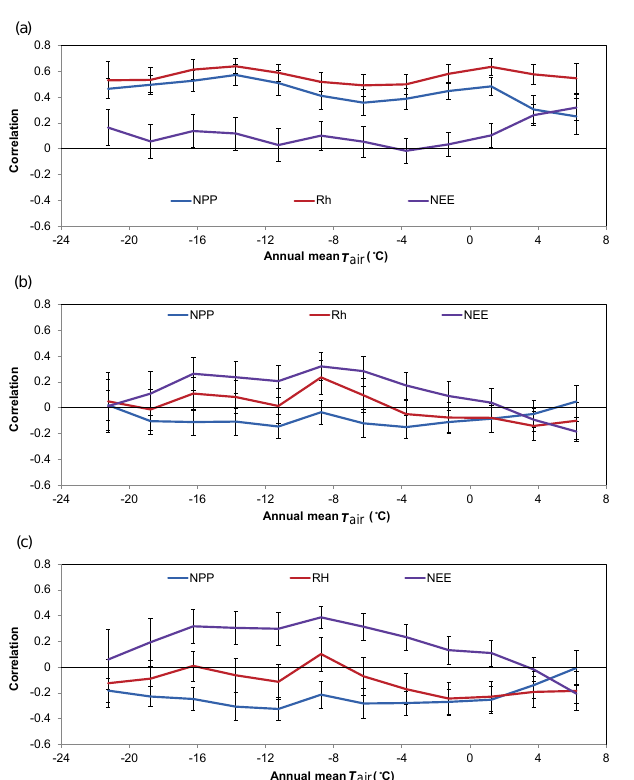
Figure 7. Correlations between climate variables and warm-season (May–October) soil heterotrophic respiration ( R h ) contribution from different soil organic carbon (SOC) pools (i.e., R h fraction). The climate variables used for the correlation analysis in each panel are (a) warm-season air temperature ( T air ), (b) preseason snow wa- ter equivalent (SWE), and (c) preseason snow cover extent (SCE). The correlations were binned into 2.5 ◦ C intervals. The three litter- fall SOC pools were distributed in the top 0.2m of the soil layers; the three SOC pools with fast turnover rates were distributed in the top 0.5m of the soil layers; the deep SOC pool with slow turnover rates extended from 0.5 to 3m below surface. The standard devia- tion of correlations across each climate zone is shown by the error bars.